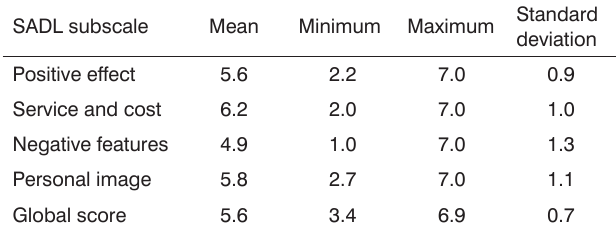
Table 2. SADL global and subscale scores of the patients included in this